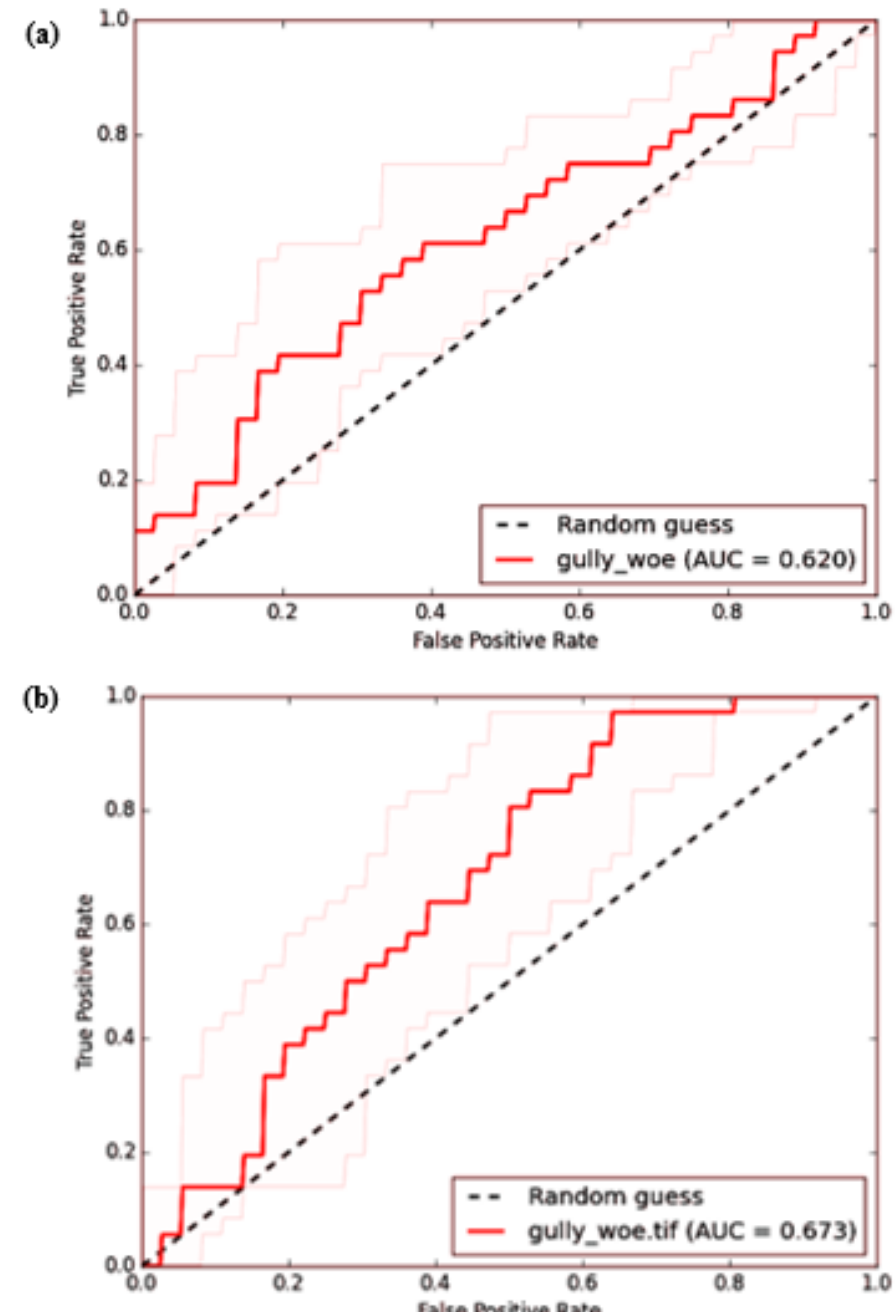
Figure 10. Prediction rate curve for gully erosion susceptibility map using WoE in Kakia- Esamburmbur catchment: ( a ) training and ( b ) validation.